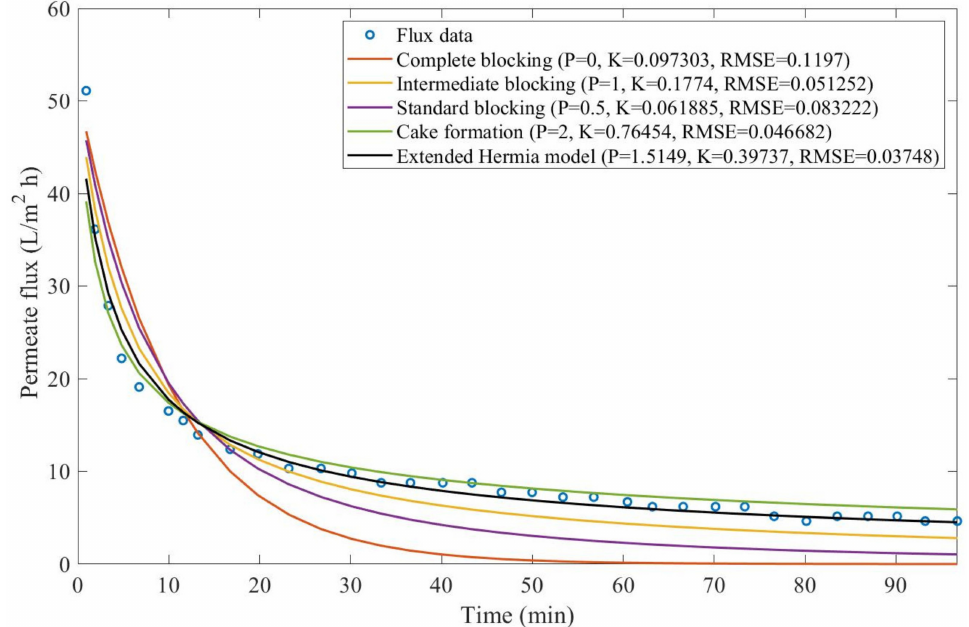
Figure A21. Model fitting for oily effluent ultrafiltration with CFR of 40 L/min and 21 kPa considering the four original pore-blocking mechanisms and the extended Hermia model